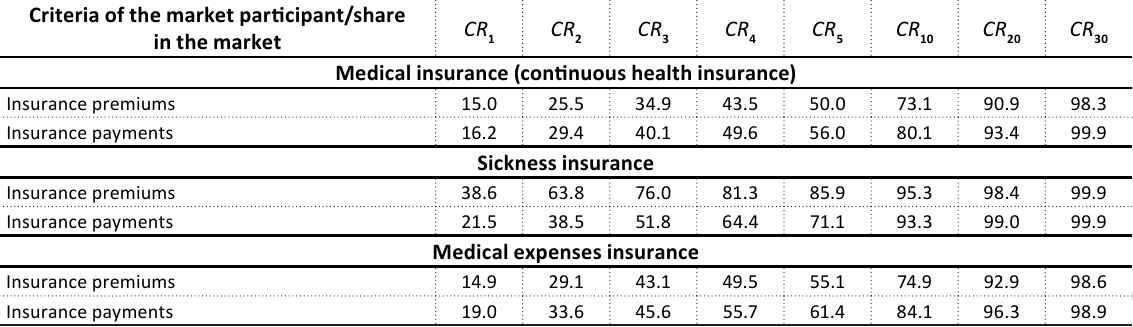
Table 1. Concentration indicators of the voluntary health insurance market with pointing out its components according to the selected criteria (as of January 1, 2018), % Source: Calculated according to the data of Insurance